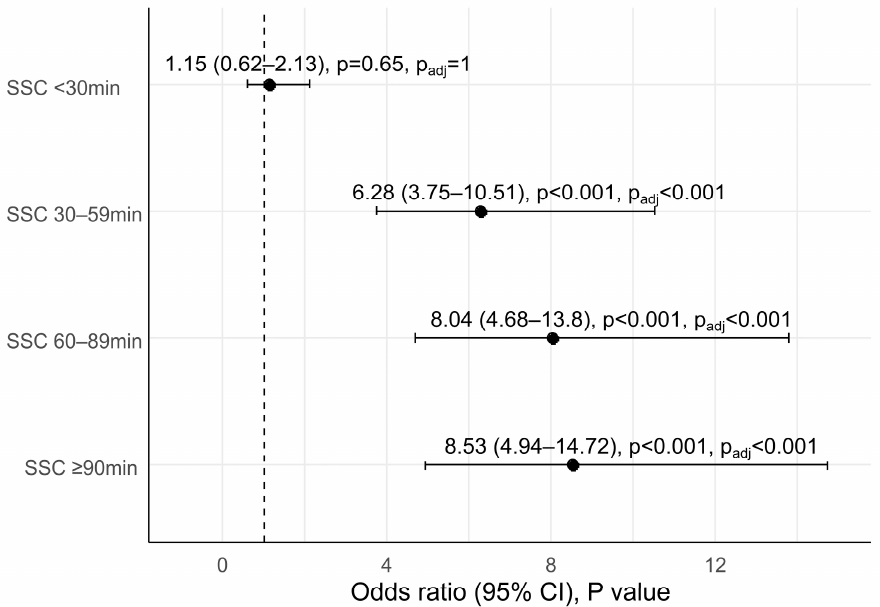
Figure 1. Association between SSC duration after caesarean section and early initiation of breastfeeding.